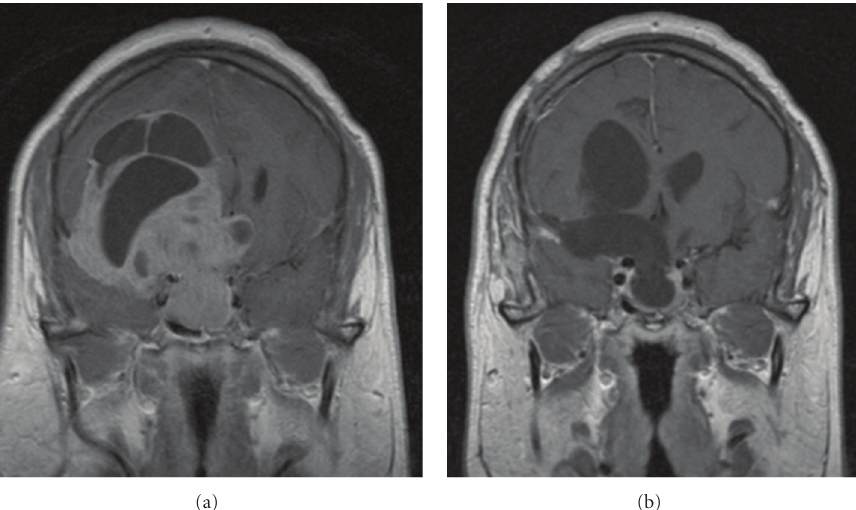
Figure 10: Enhanced MRI coronal view of a giant tumor growing toward the middle cranial fossa (a). A combined TCr approach was used in this case and even though the whole tumor could be removed (b), acromegaly persisted and the patient was treated with somatostatin